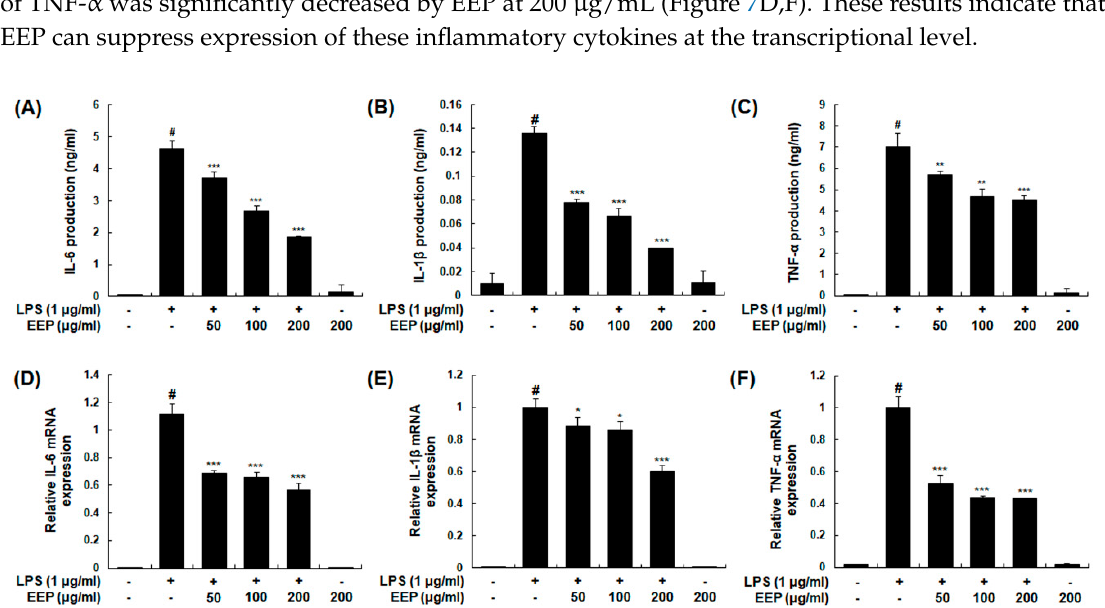
Figure 7. Effects of EEP on production and mRNA expression of pro-inflammatory cytokines in RAW 264.7 macrophages. ( A – C ) Following treatment with EEP (50, 100, or 200 µ g/mL) for 1 h, cells were stimulated with LPS (1 µ g/mL) for 24 h. Production of IL-6, IL-1 β , and TNF- α in the culture media was determined using EIAs kits. Control cells were not treated with LPS or EEP. ( D – F ) Total RNAs were prepared for qRT-PCR analysis of IL-6, IL-1 β , and TNF- α in cells stimulated with LPS (1 µ g/mL) for 2 h (TNF- α ) or 6 h (IL-6 and IL-1 β ) with or without treatment with EEP. mRNA levels of IL-6, IL-1 β , and TNF- α were determined using gene specific primers. Results were normalized against β -actin. Experiments were repeated three times and similar results were obtained. Values shown are means ± SDs of three independent experiments. # p < 0.05 vs. control group; * p < 0.05, ** p < 0.01, *** p < 0.001 vs. LPS-stimulated group.